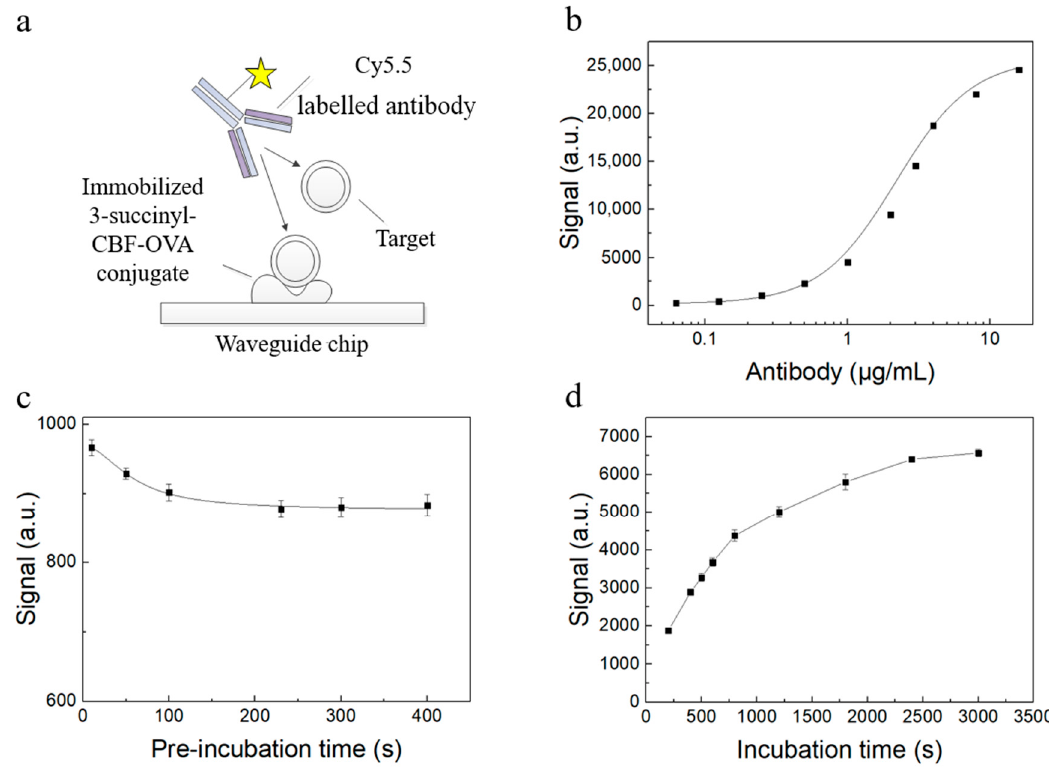
Figure 2. Schematic representation of the developed biosensor and its experimental optimization results. ( a ) Schematic representation of the competitive type of waveguide-based fluorescent biosensing immunoassay; relationships among the fluorescence signals and ( b ) the concentration of the Cy5.5-labeled CBF antibody, ( c ) preincubation time for 5 ng / mL CBF, and ( d ) incubation time for blank sample. Each data represents the average intensity with S.D. in triplicates.